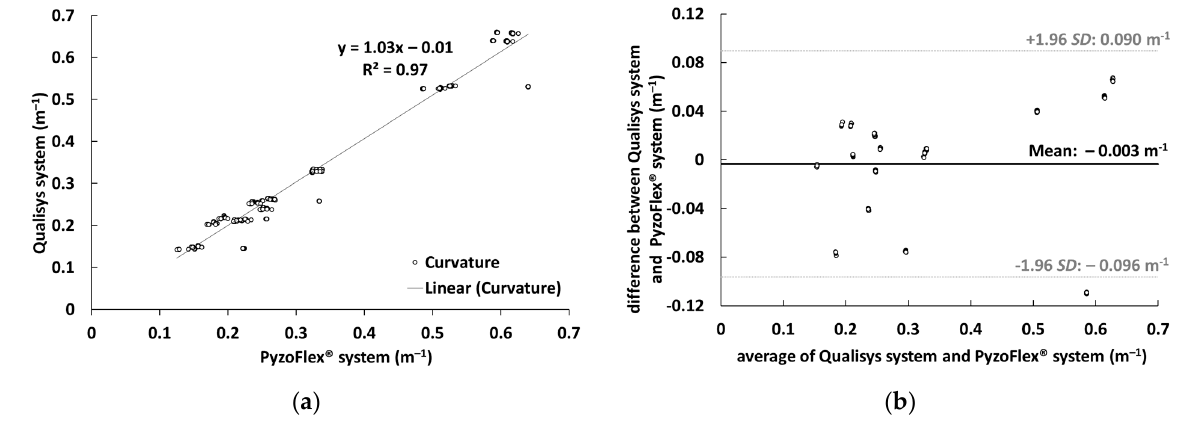
Figure 7. ( a ): Correlation between the curvature (m − 1 ) that was measured by Qualisys system (criterion instrument) and PyzoFlex ® sensor system. ( b ): Bland–Altman plot showing the difference against the average of Qualisys system and PyzoFlex ® sensor system with limits of agreement (LoA) (dotted lines). SD: Standard deviation.